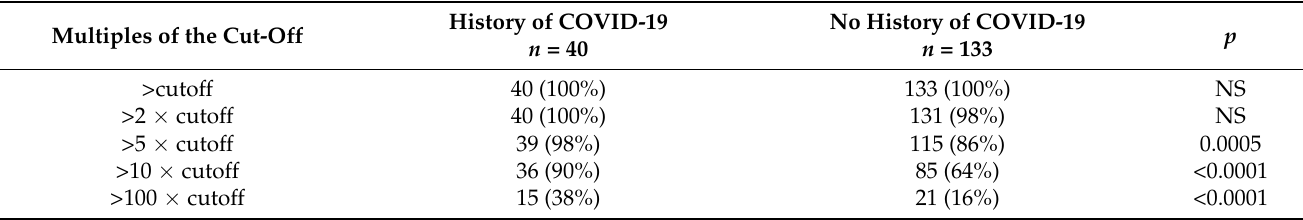
Table 1. Prevalence of anti-S antibodies at the levels exceeding multiples of the cut-off determined for the positive result in individuals with and without a history of clinical COVID-19; NS—not significant. Multiples of the